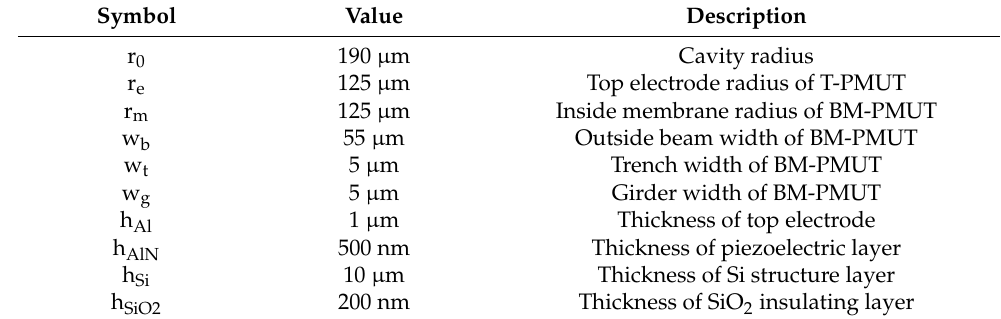
Figure 1. ( a ) Schematic of the BM-PMUT. ( b ) Cross-section structure of A–A’. ( c ) Optical micrograph of the BM-PMUT. ( d ) Optical micrograph of the T-PMUT. Table 1. Summary of the structure parameters.